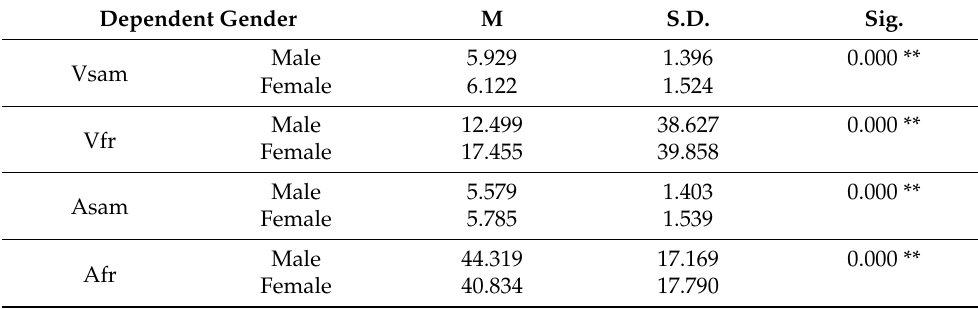
Table 4. Independent sample T tests of gender